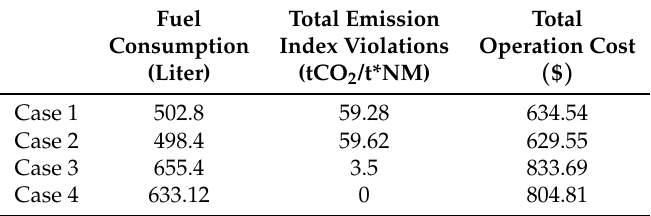
Table 4. Comparing the fuel consumption, emission, and operation cost in different